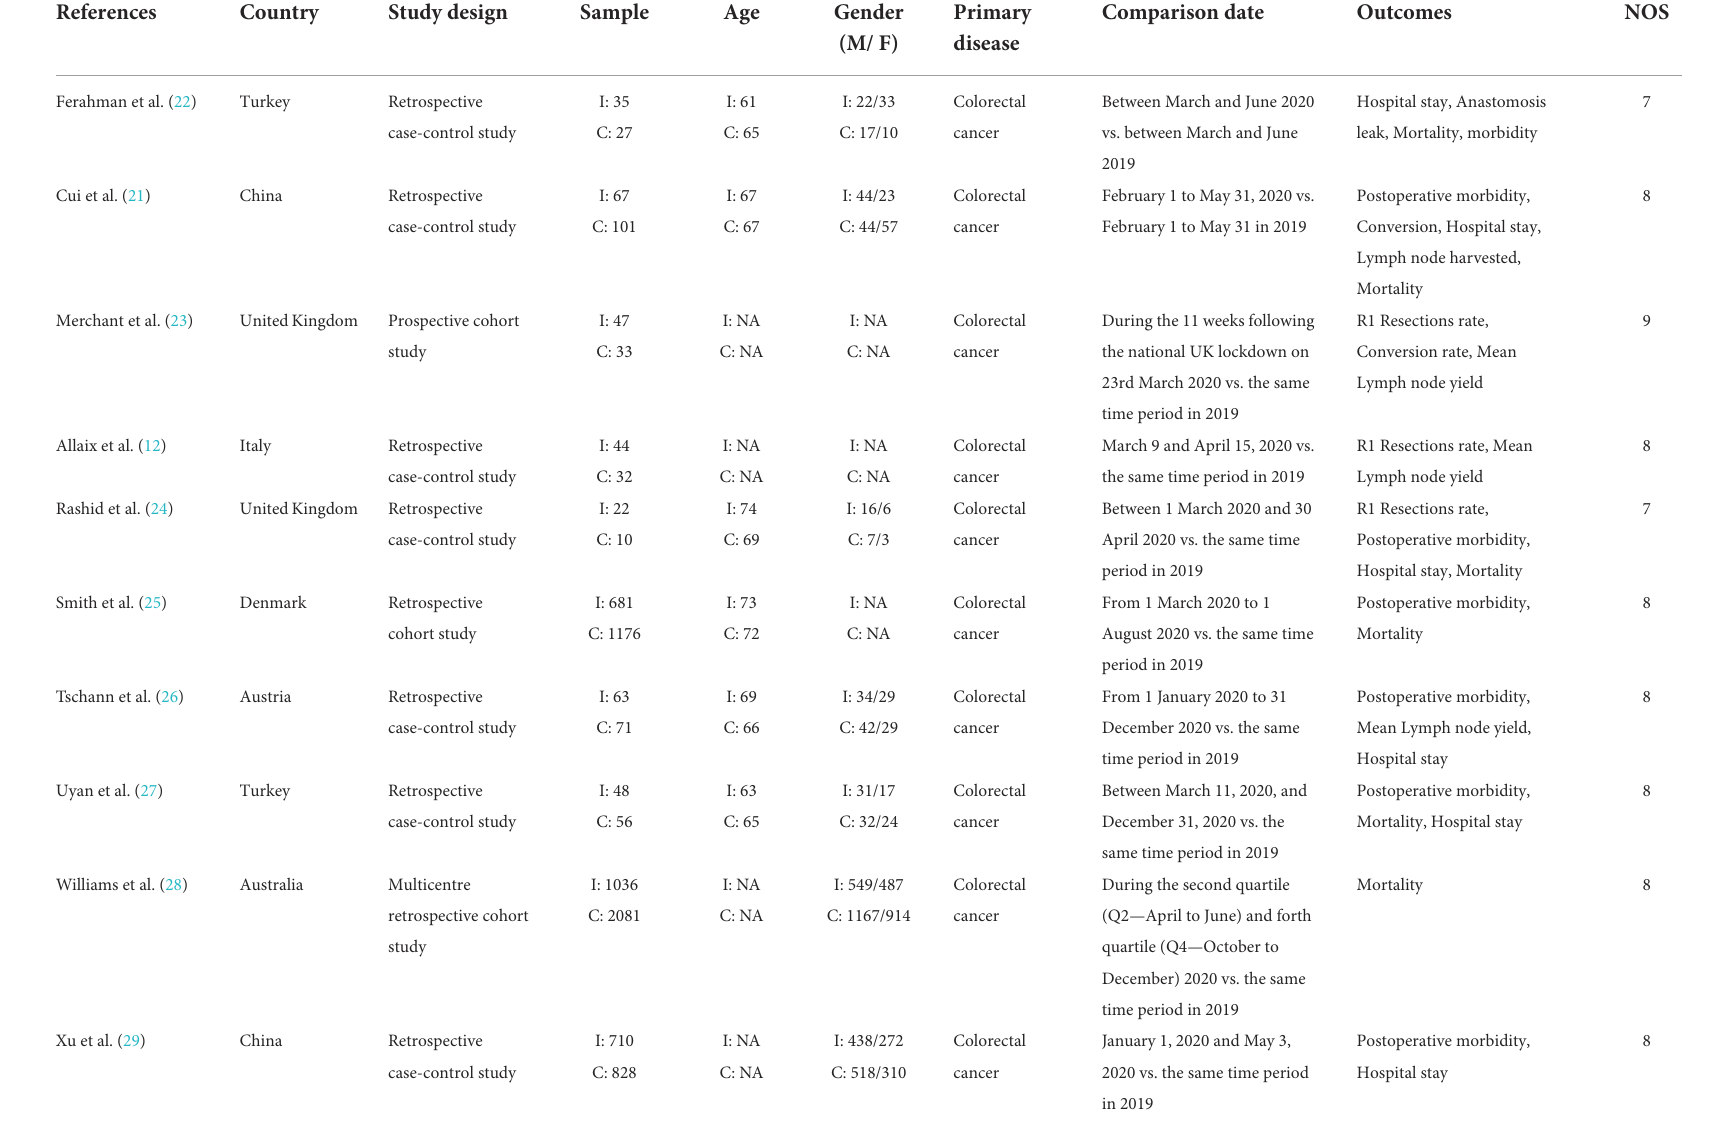
TABLE 3 Characteristics of trials included in the